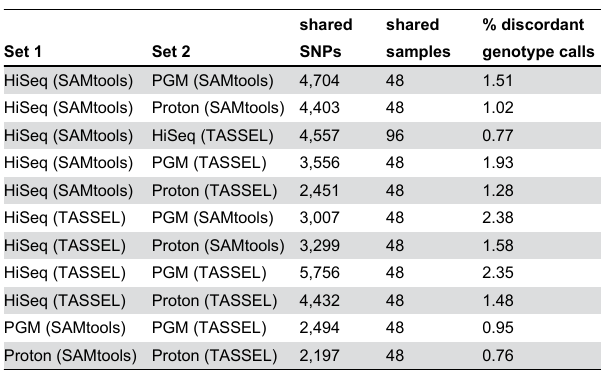
Table 2. Comparison of single nucleotide polymorphism (SNP) genotype calls for Morex x Barke recombinant inbred lines from genotyping-by-sequencing datasets using three different sequencing platforms (Illumina HiSeq 2000, Ion Torrent Proton and Ion Torrent